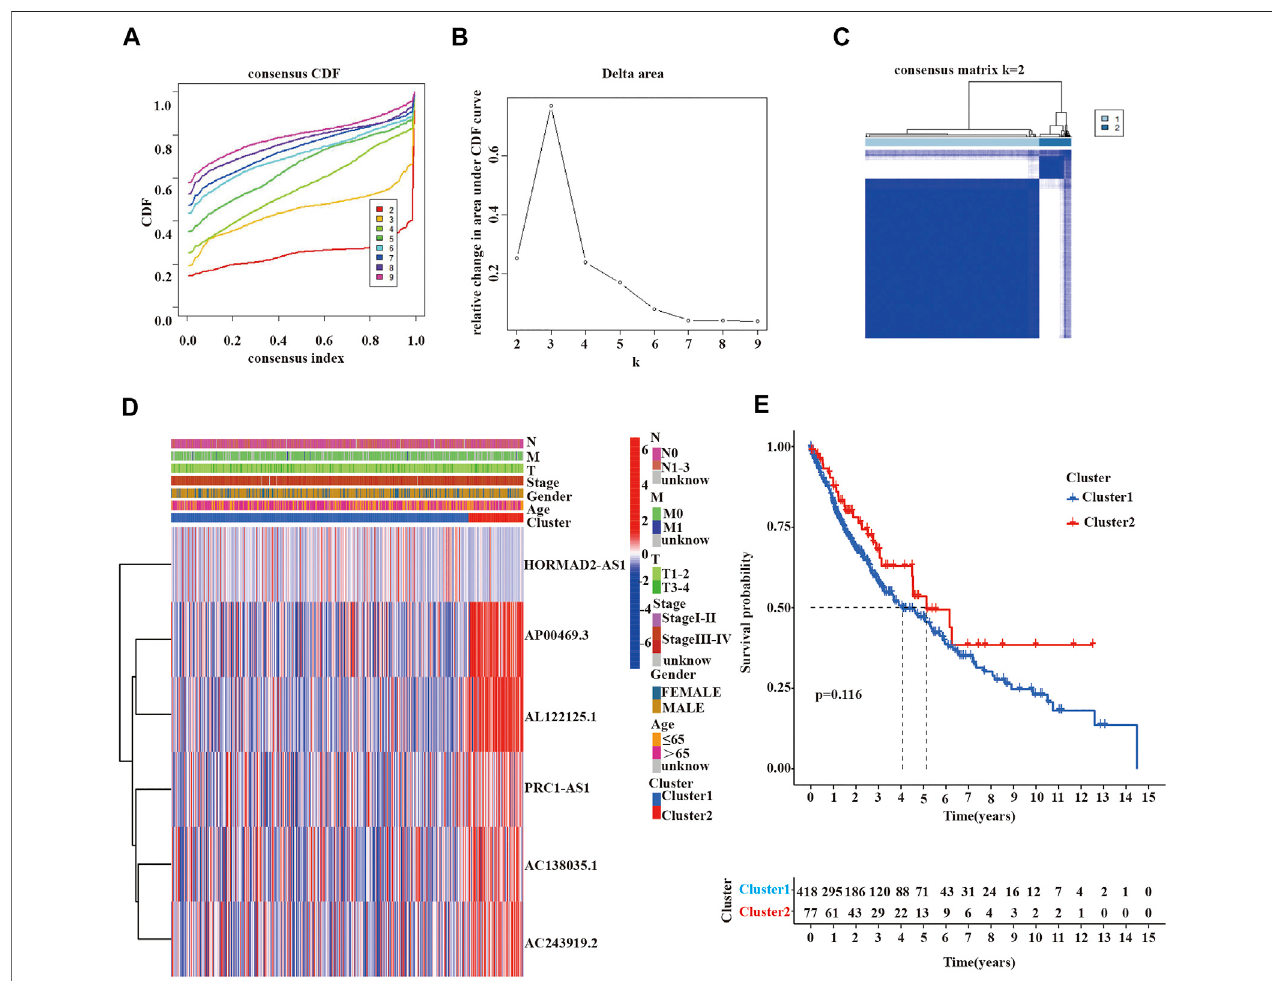
FIGURE3| Clinicopathologicalcharacteristicsandsurvivalanalysisofcluster1/2subgroupsofLUSC. (A,B) Consensusclusteringcumulativedistribution function (CDF) for k = 2 to 9. (C) Consensus clustering matrix for k = 2. (D) Heatmap of the correlation between the expression levels of 6 m 6 A-related lncRNAs with prognostic value and clinicopathological features in the TCGA-LUSC dataset (red indicates high expression, blue indicates low expression). (E) Kaplan-Meier curves of overall survival for two clusters in LUSC. LUSC, lung squamous cell carcinoma; m 6 A, N 6 -methyladenosine; lncRNAs, long non-coding RNAs; TCGA, the cancer genome atlas; Statistical methods: Chi-square test, log-rank